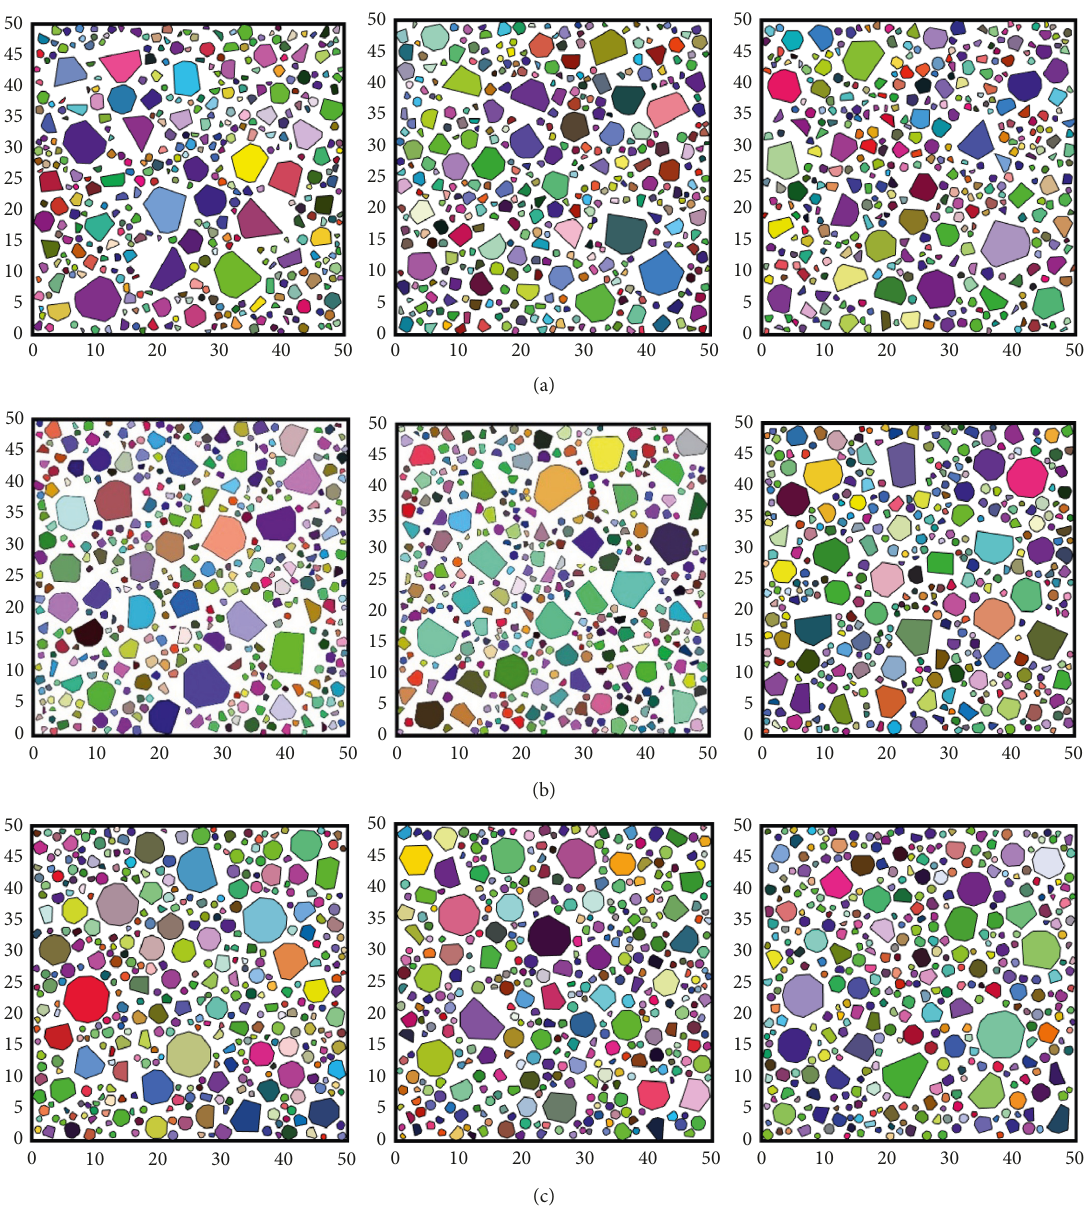
� 0.475, r � 4, Q � 30%, n � 4–10, α � 200 ° , α � 10 ° ; (b) min max s 1 2